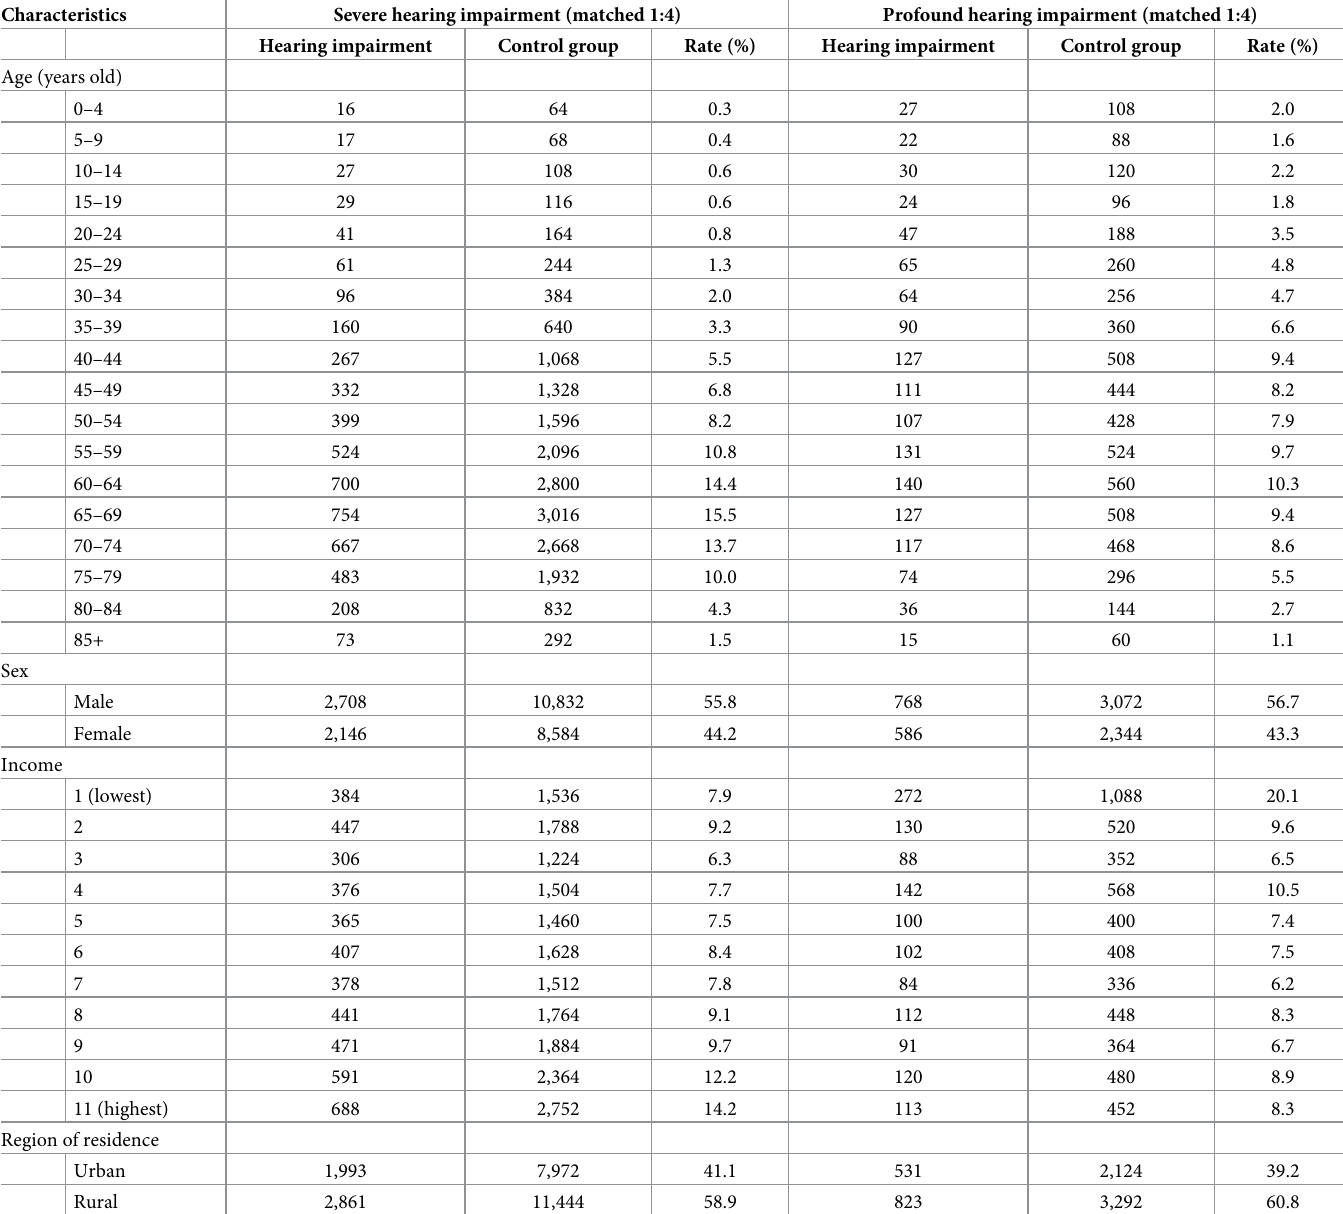
Table 1. General characteristics of